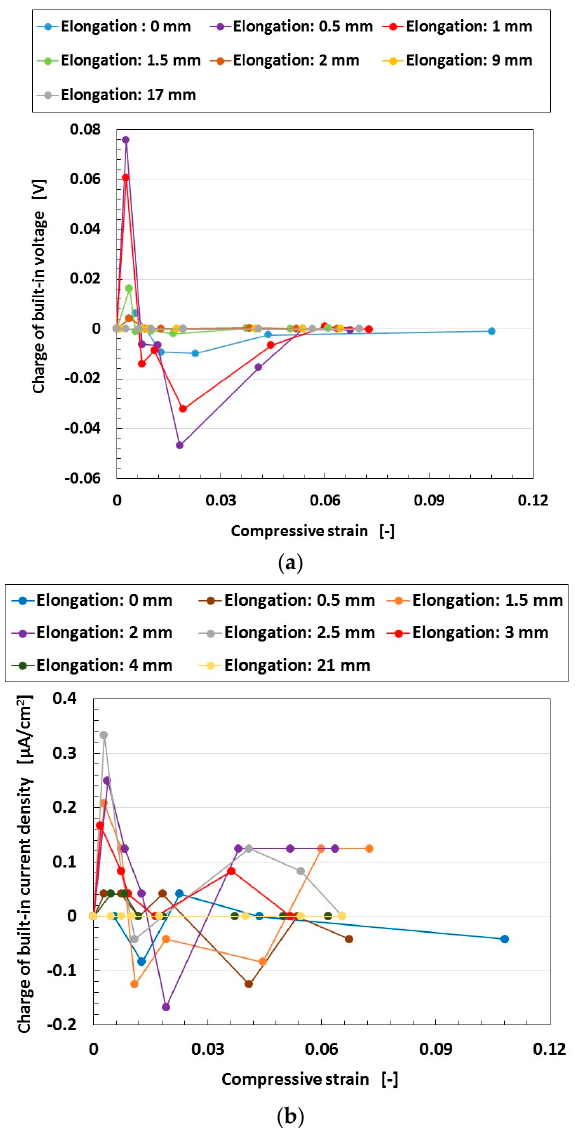
Figure 12. Charge of built-in electricity under compression and elongation at turning ultraviolet light on for a wet-type MCF rubber solar cell electrolytically polymerized under a magnetic field with 0.22 g of Ruthenium complexes dye and 7.4 g of KI+I 2 electrolyte: ( a ) voltage; ( b ) current density. The MCF rubber had 3 g of TiO 2 , 6 g of Ni, 4.5 g of MF, and 9 g of NR-latex. The irradiation light was ultraviolet (40 lx). The experimental apparatus and procedure were the same as those used in the second report [19].